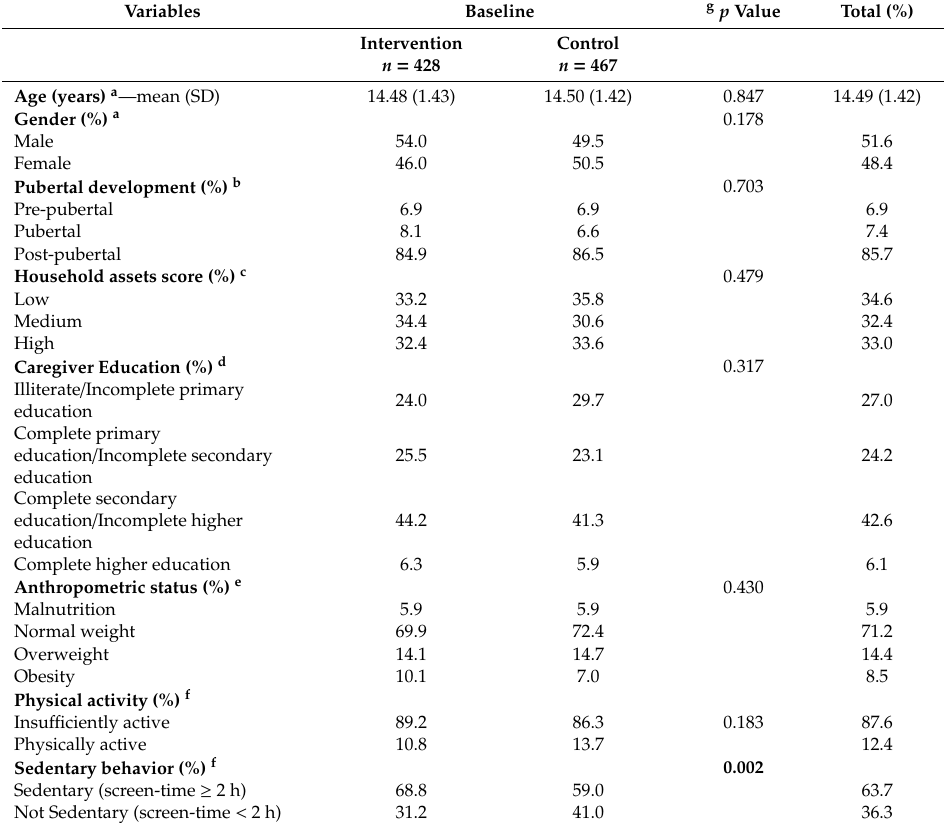
Table 3. Characterization of the study groups at baseline. Salvador -BA,